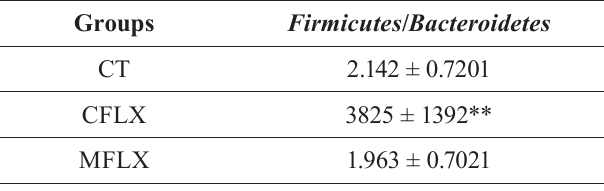
TABLE IV - Effect of ciprofloxacin and moxifloxacin on Firmicutes / Bacteroidetes ratio in large intestine Groups Firmicutes /